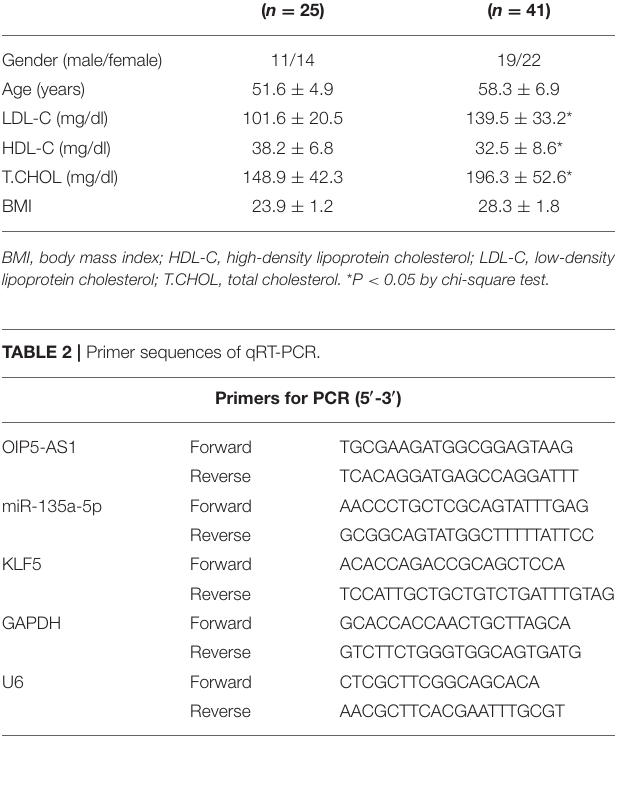
TABLE 1 | Clinicopathologic features of atherosclerosis patients and healthy controls. Parameters